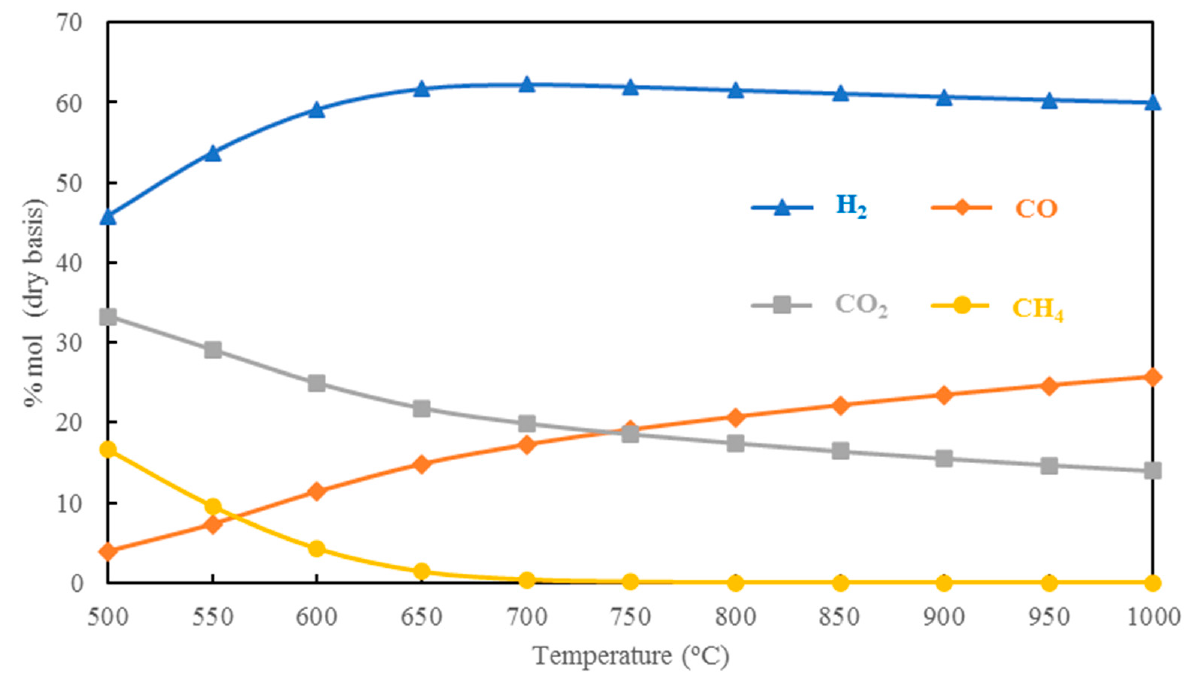
Figure 3. Effect of gasification temperature on the gas product composition exited from the gasifier at an S/F mass ratio = 1, CaO/F mass ratio = 1, carbonator temperature = 450 °C, and regenerator temperature = 950 °C.